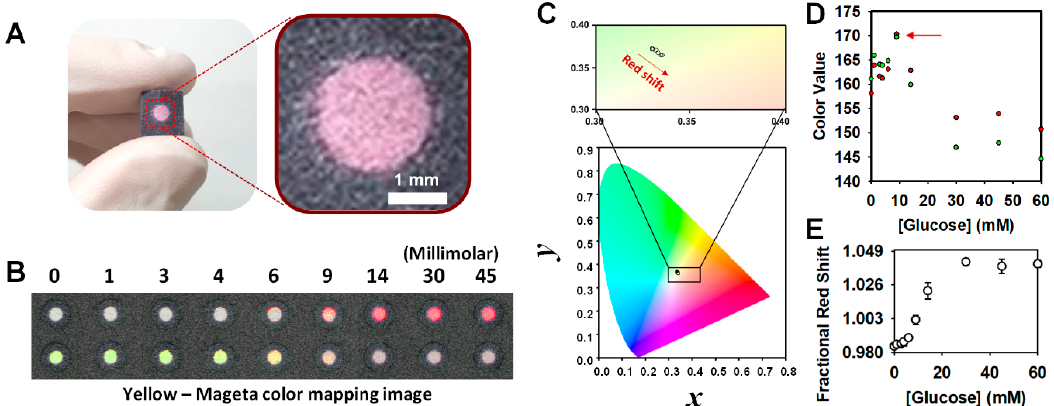
Figure 1. Chromatic characteristics of plasmonic paper. ( A ) Macroscopic view over the plasmonic paper; ( B ) color transition in the reaction showing diminishing coloration in both red and yellow around at 9 mM; ( C ) chromatic diagram indicating a redshift corresponding to naked-eye detection; ( D ) RGB profile demonstration a loss of coloration in the middle of the concentration range; ( E ) fractional red shift index, composing with R divided by G, making a sigmoidal curve (conditions: 24 °C, humidity = 60%, N = 5). In the glucose assay, we readily observed a red shift by glucose concentrations with naked eyes.